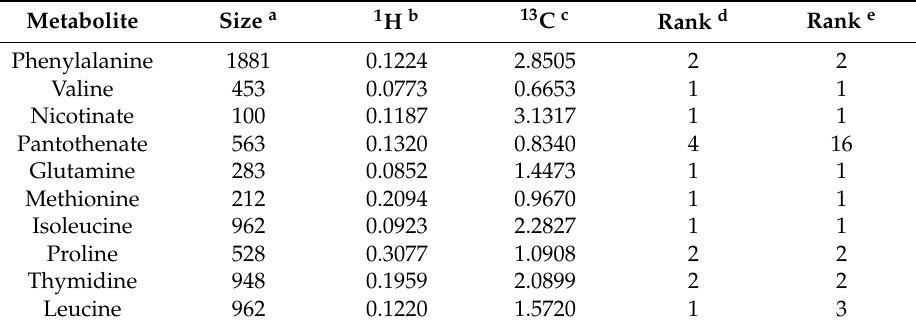
Table 2. NMR results for ten commonly known